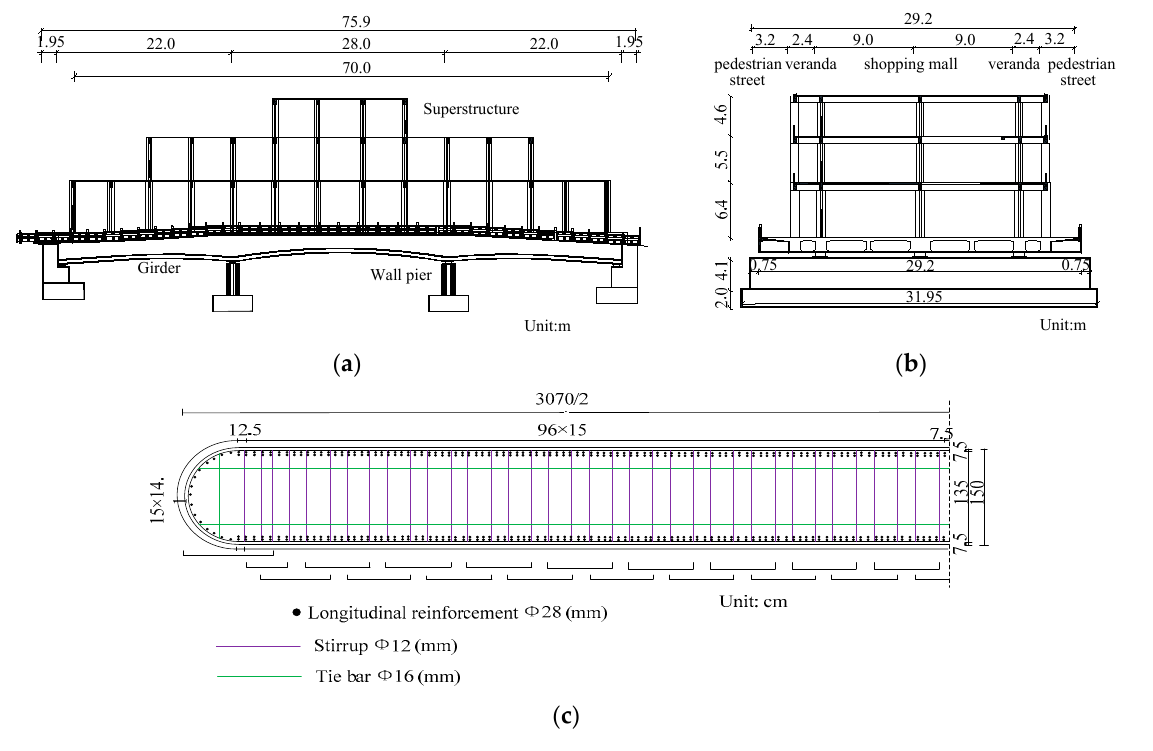
Figure 1. Details of the wall pier: ( a ) Elevation of the wall pier; ( b ) Side view of the wall pier; ( c ) Dimension and reinforcement arrangement of wall pier.